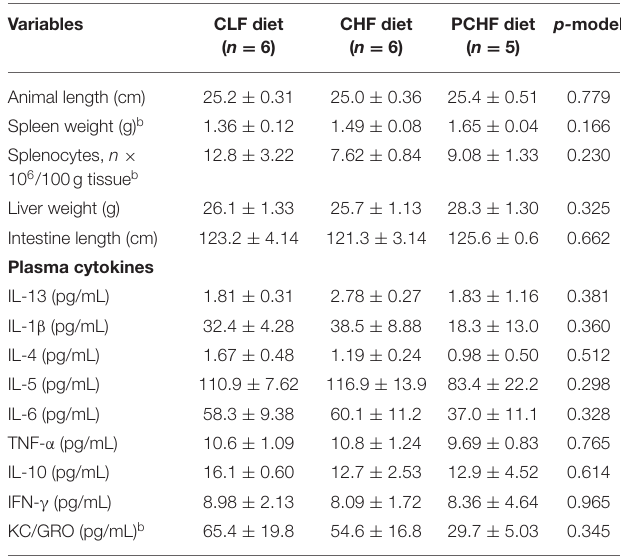
TABLE 3 | Anthropometric and plasma cytokine data of male Wistar rats fed the three experimental diets a .